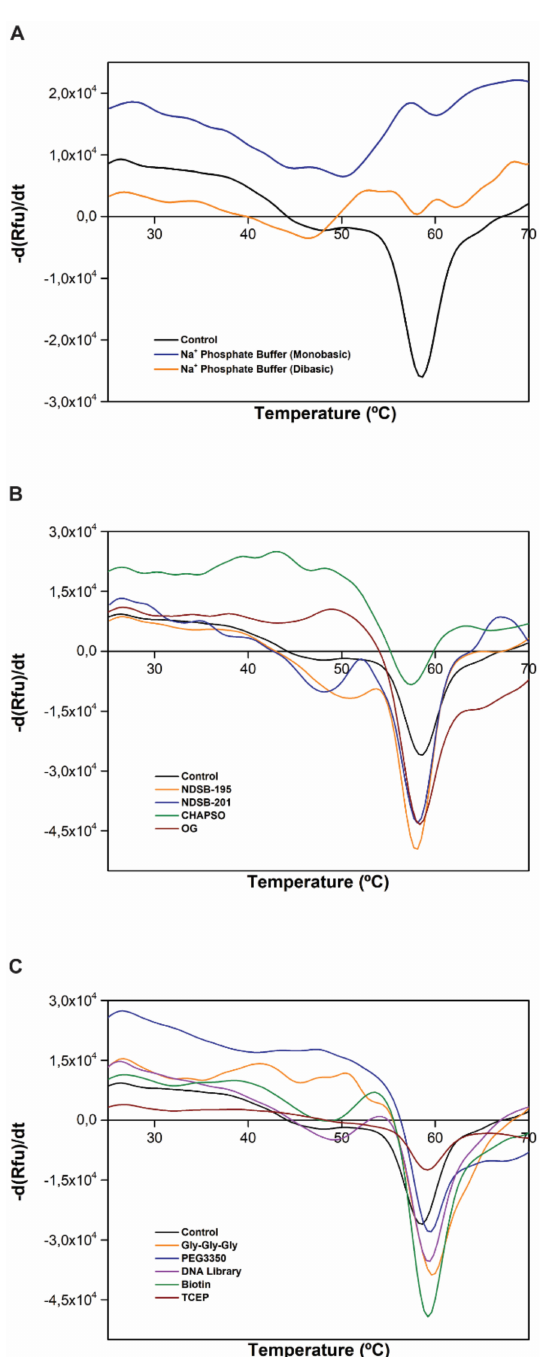
Figure 4. TSA melting curves of STEAP1 obtained from thermal stability fluorescence data of first derivative (d(Rfu)/dt) with RUBIC Additive Screen Kit for the control experiment, exhibiting a T m of 58.74 ◦ C and ( A ) in sodium phosphate buffer mono- and dibasic; ( B ) in non-detergents (NDSB-195 and NDSB-201, with a T m of 58.21 ◦ C and 58.25 ◦ C, respectively) and detergents (CHAPSO and OG, with a T m of 57.57 and 58.46 ◦ C, respectively); ( C ) in best thermal stabilizer additives (Gly-Gly-Gly, PEG3350, DNA Library, Biotin, and TCEP, with a T m of 59.72, 59.64, 59.53, 59.31, and 59.29 ◦ C,